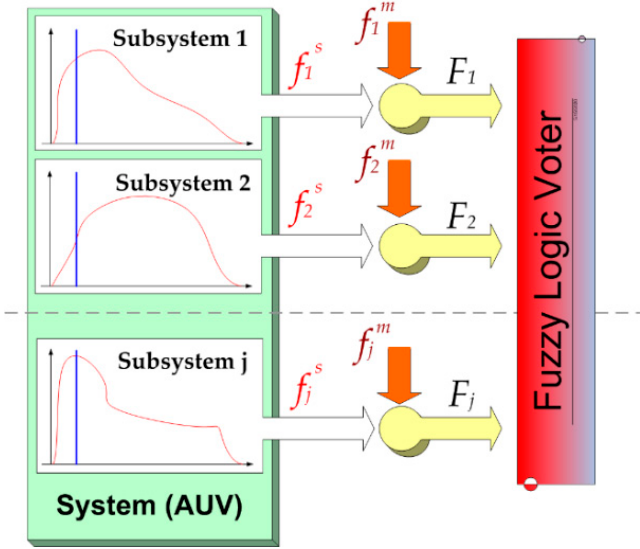
Figure 4. Fuzzy logic voter block diagram.